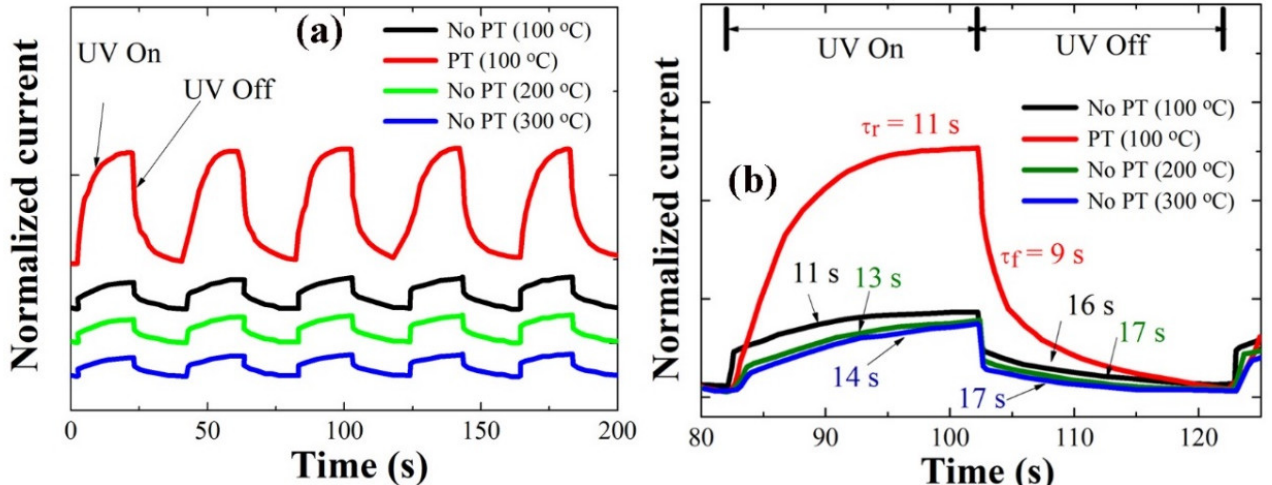
Figure 8. ( a ) Transient characteristics of p-Si/n-ZnO-NRs heterojunction PDs grown on the SLs pre- pared under different conditions; ( b ) the expanded views of the photoresponses in a single cycle in ( a ).